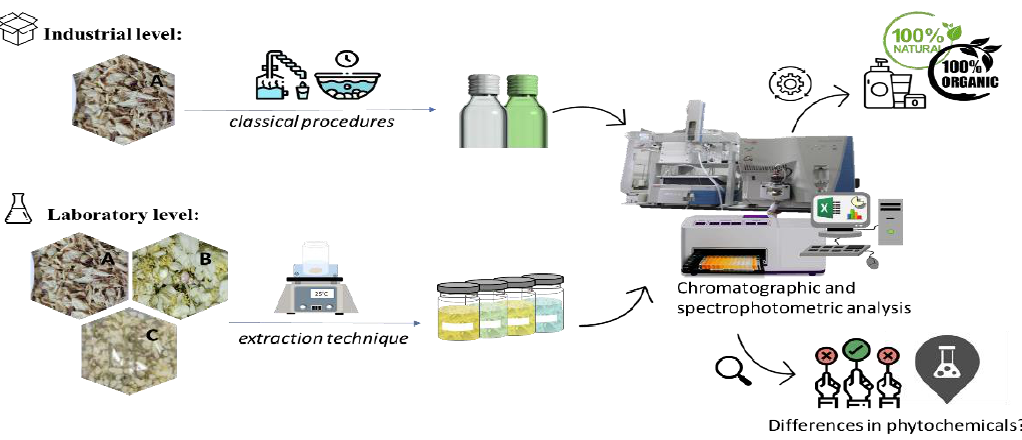
Figure 1. Proposed work approach: dried ( A ), fresh ( B ), and frozen ( C ) samples.